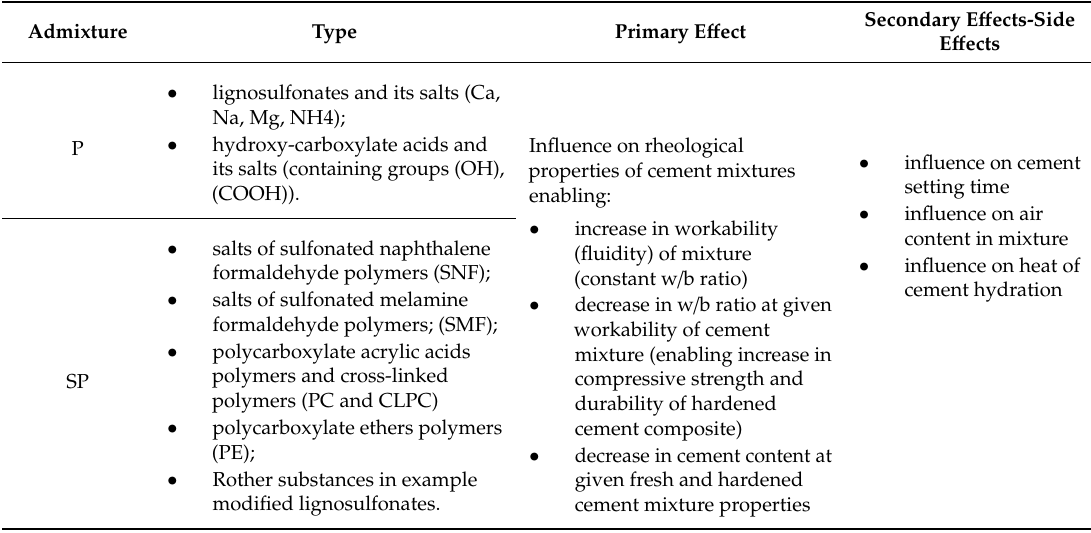
Table 1. Types, primary and secondary e ff ects of plasticizers (P) and superplasticizers (SP) [24].